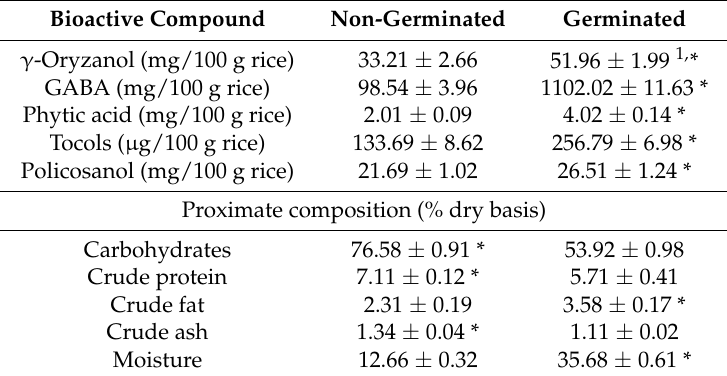
Table 1. Bioactive components and proximate composition of Superhongmi rice powder.